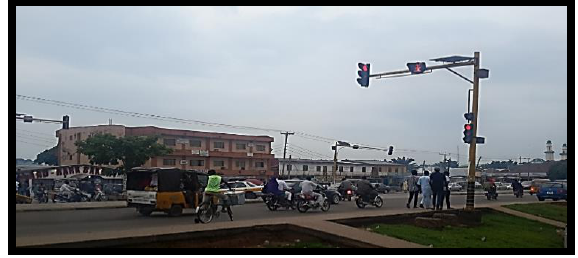
Figure 6. Instance of Adherence of Road Users to Traffic rules in the Presence of FRSC